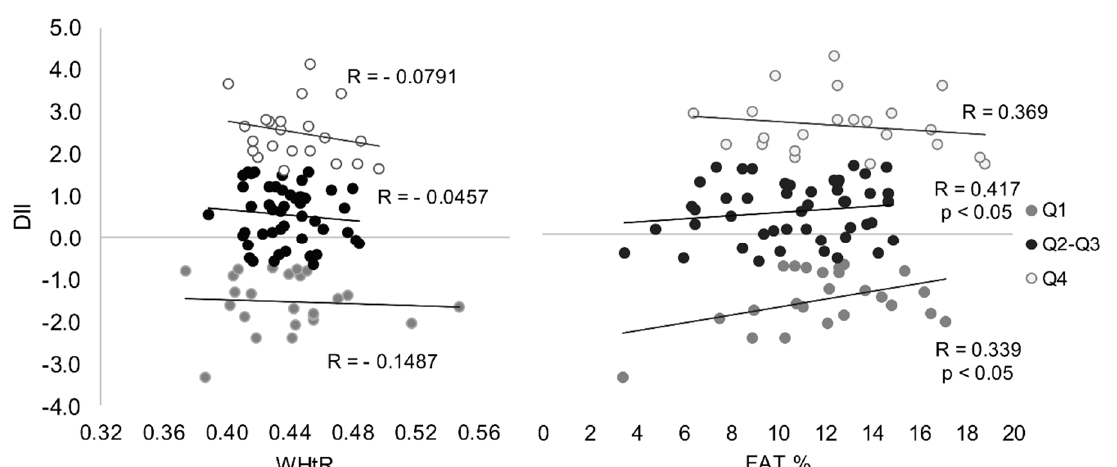
Figure 3. Correlation between DII and WHtR ( left ) and FAT ( right ) content in men with different DII. Table 3. Spearman’s simple correlation coefficients for hs-CRP, DII, FAT and WHtR.